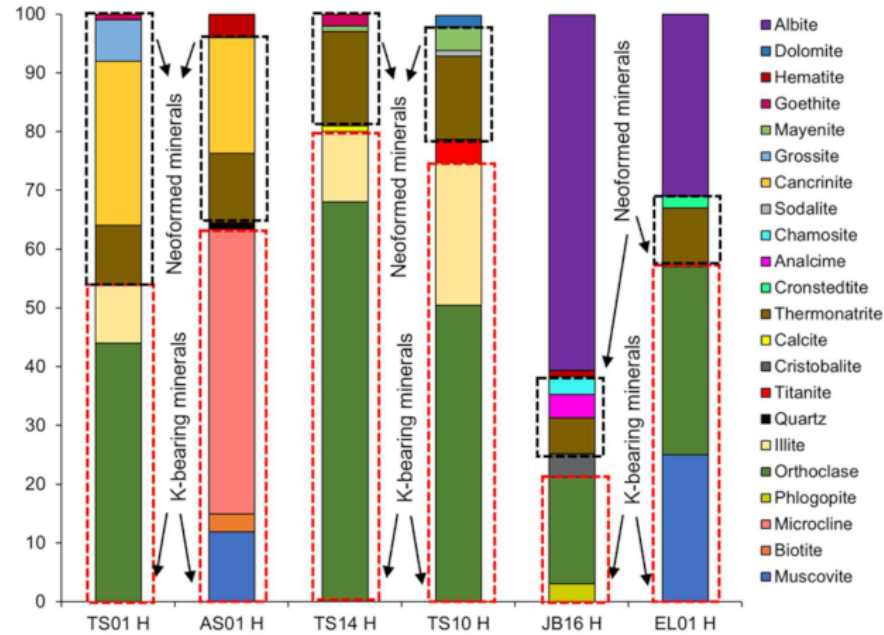
Figure 5. Mineralogical composition of the treated samples using XRD